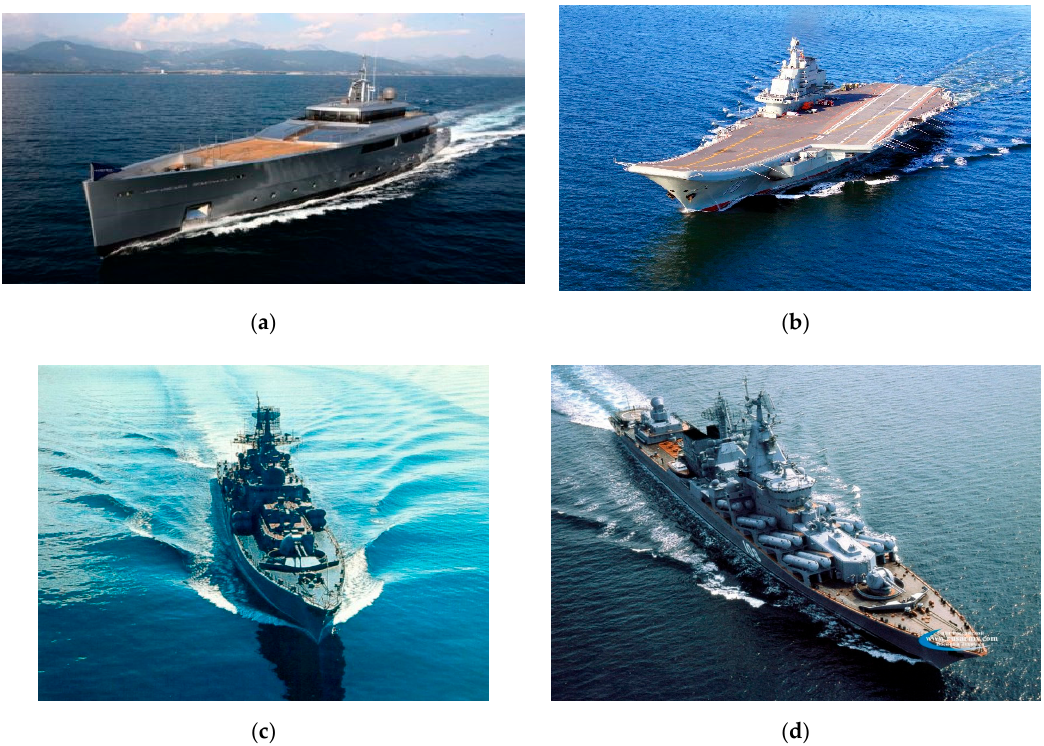
Figure 7. Photos of ships with the visible shift of the bow Kelvin waves system. ( a ) Yacht of the English shipyard Sunseeker; ( b ) American aircraft carrier; ( c ) destroyer; ( d ) cruiser of the project 1164type